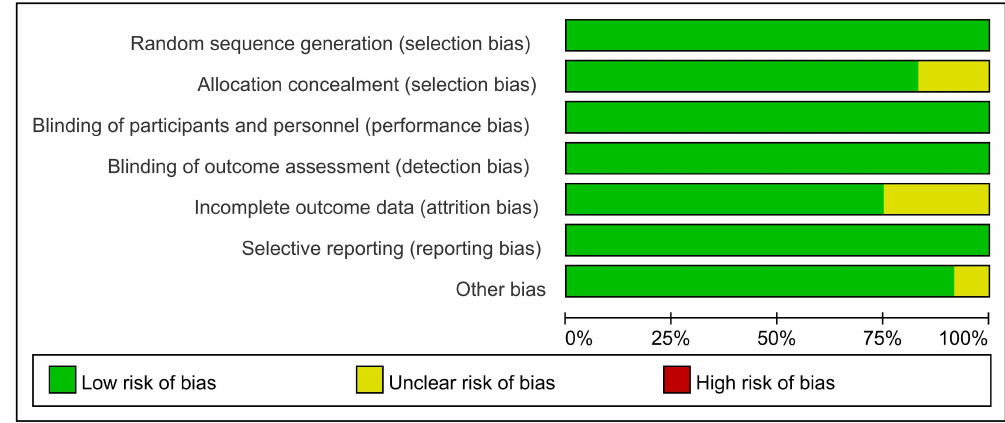
Figure 2. Risk of bias graph for included RCTs.